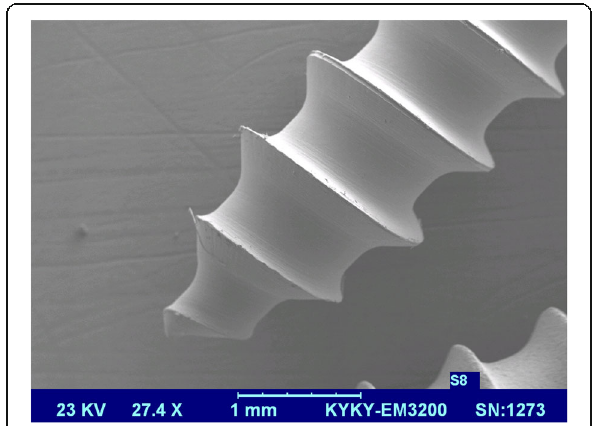
Fig. 3 Scanning electron microscope images of miniscrews in the control group